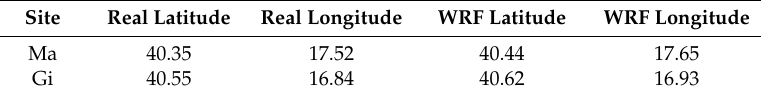
Table 1. Real and WRF coordinates for the two sites